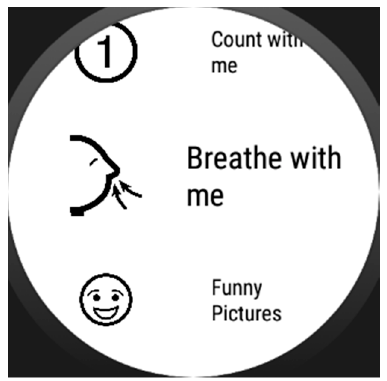
Figure 4. Self ‐ regulation strategies selector. Figure 4. Self-regulation strategies selector.